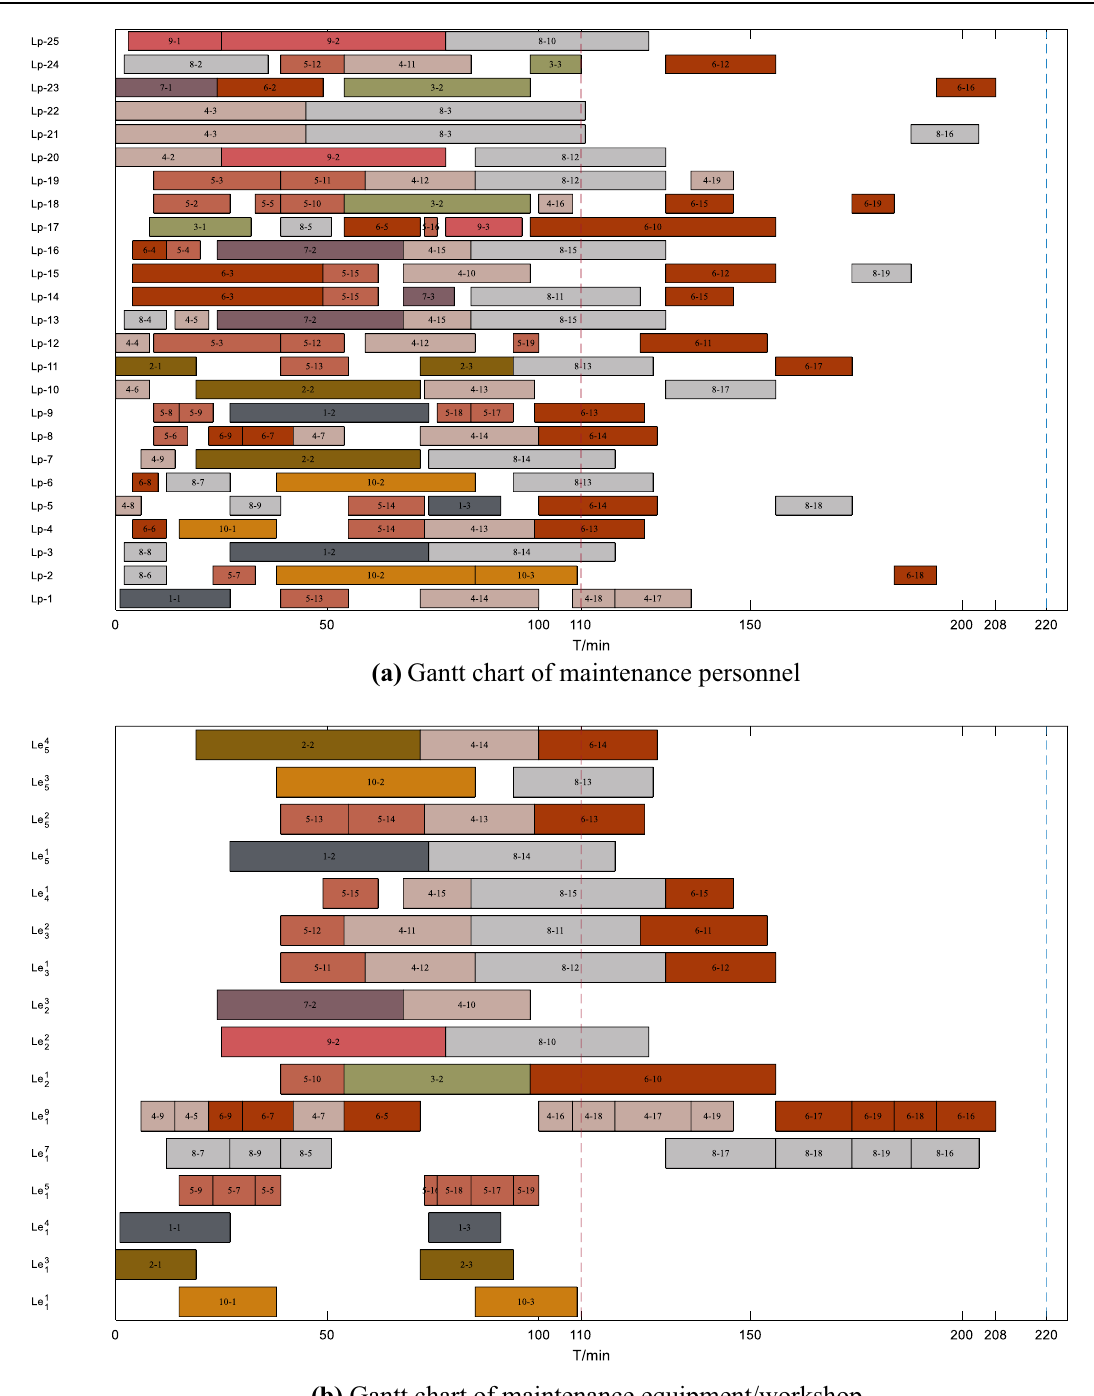
Fig. 11 Baseline schedule for 10 carrier-based aircraft